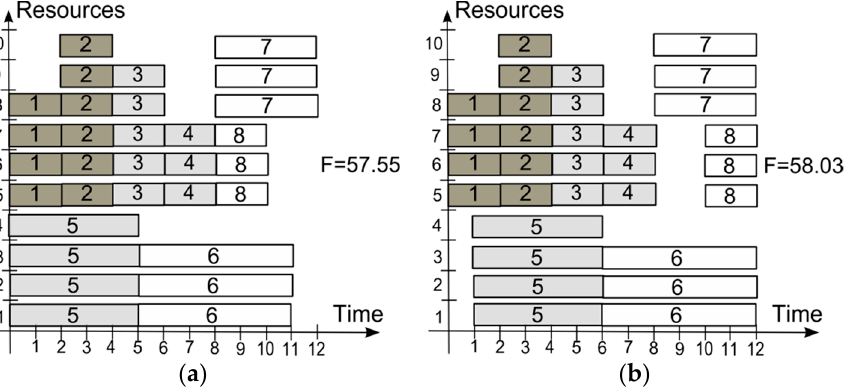
Figure 6. ( a ) Schedule with resource allocation set by the ISH-UA (iterative sample heuristic with unavoidable arcs) procedure, ( b ) schedule set using the activity right-shift procedure.